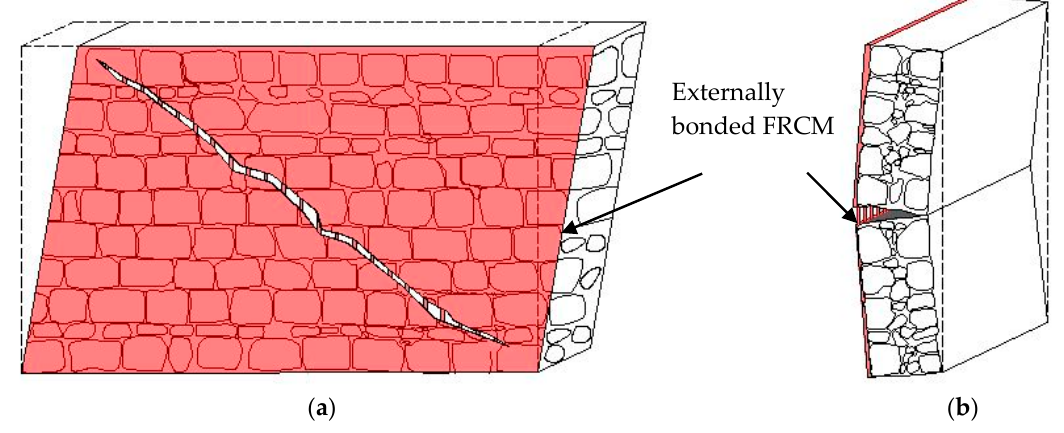
Figure 1. ( a ) In-plane and ( b ) out-of-plane strengthening of masonry walls.